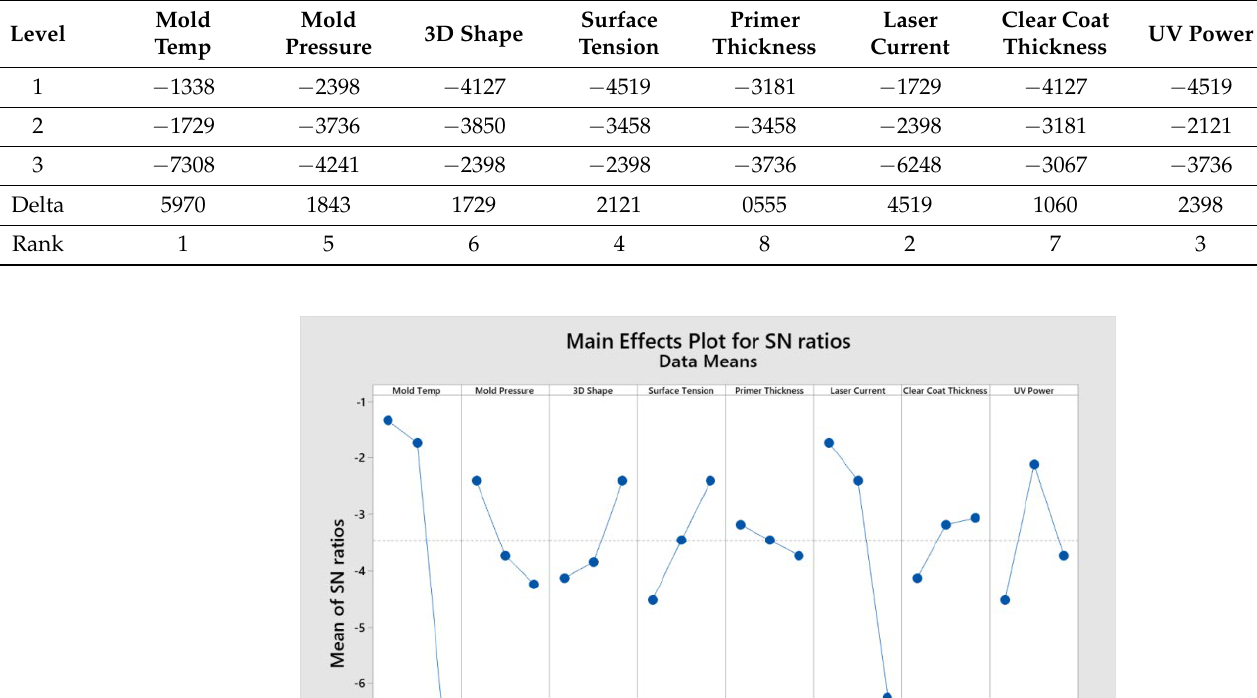
Table 4. Response Table for Signal to Noise Ratios/Smaller is better.